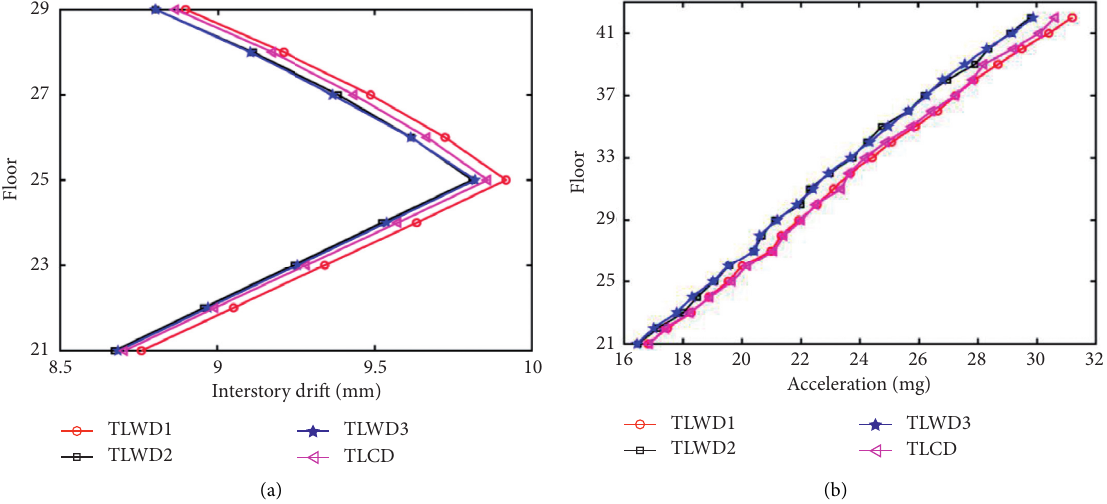
Figure 15: Mean maximum floor response profiles for TLWDs installed over the last 15 floors: (a) zoom on maximum interstory drift and (b) maximum acceleration over top 20 floors.